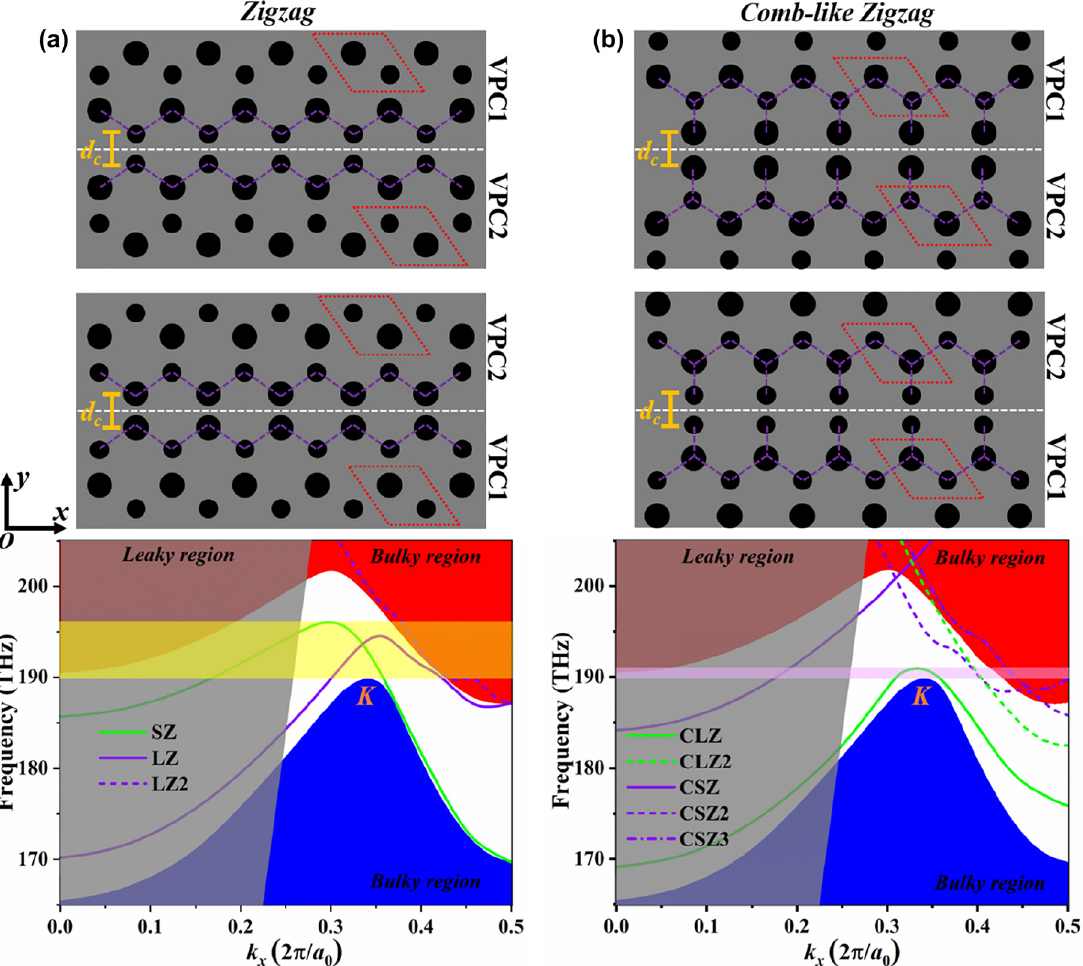
Figure 2: Schematics of valley-dependent interfaces and dispersions of valley kink states for (a) the ‘zigzag’ and (b) the ‘comb-like zigzag’ = 235 nm. Red region: TE-like valence band. Blue region: TE-like conduction band. Grey region: light cone of leaky domains walls with d c modes. Yellow region: the overlap between the valley kink state for the SZ-interface and the bandgap at the K / K ′ point. Magenta region: the overlap between the valley kink state for the CLZ-interface and the bandgap at the K / K ′